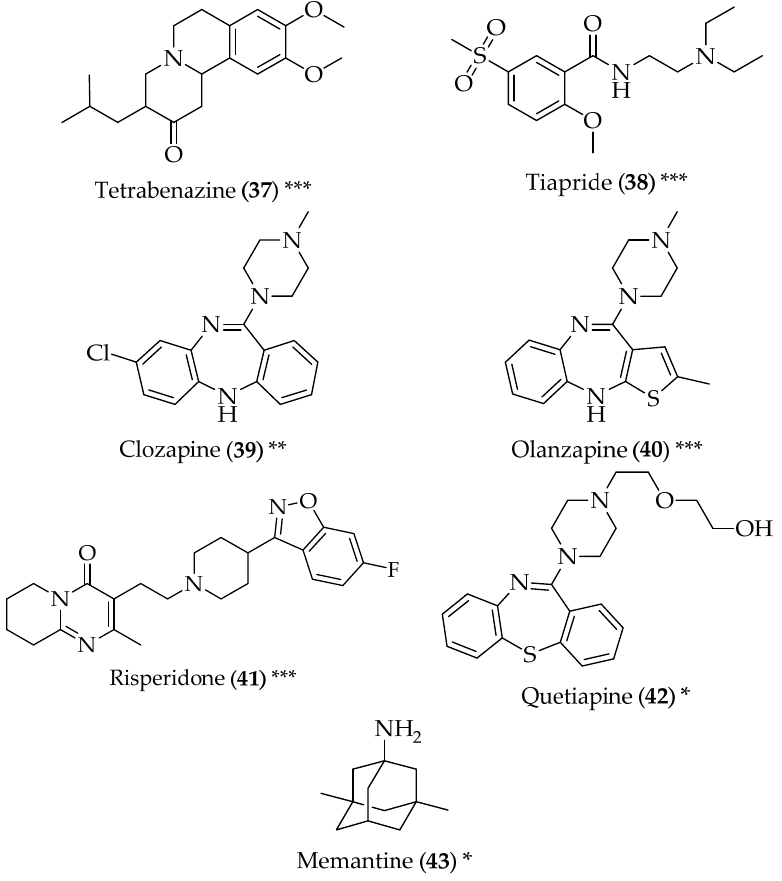
Figure 4. Structure of drugs 37 – 43 (*) Preclinical Studies; (**) Under clinical studies; (***) Clinically approved.